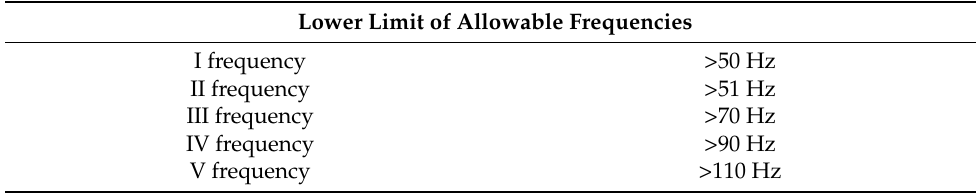
Table 1. Design constrain